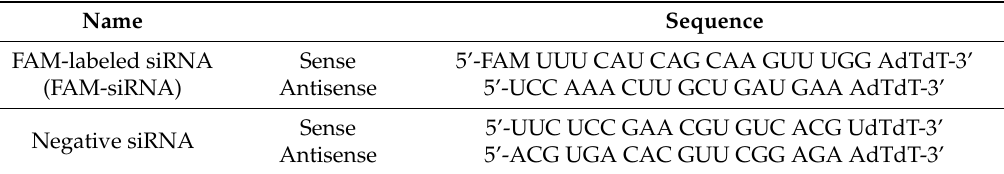
Table 1. Sequences of small interfering RNAs (siRNAs). FAM: 5-carboxy-fluorescein.